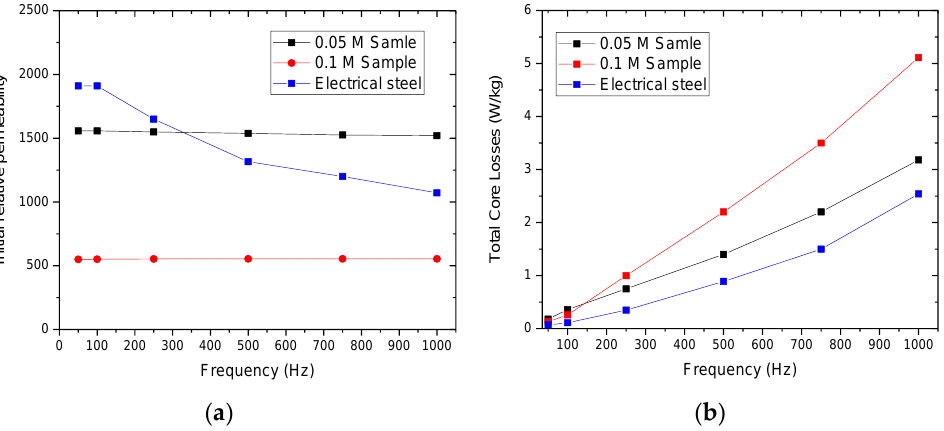
Figure 14. Evolution of ( a ) the initial relative permeability ( µ ri) and ( b ) the total core losses versus the frequency for 0.05 M sample, 0.1 M sample and 3% Si electrical steel.